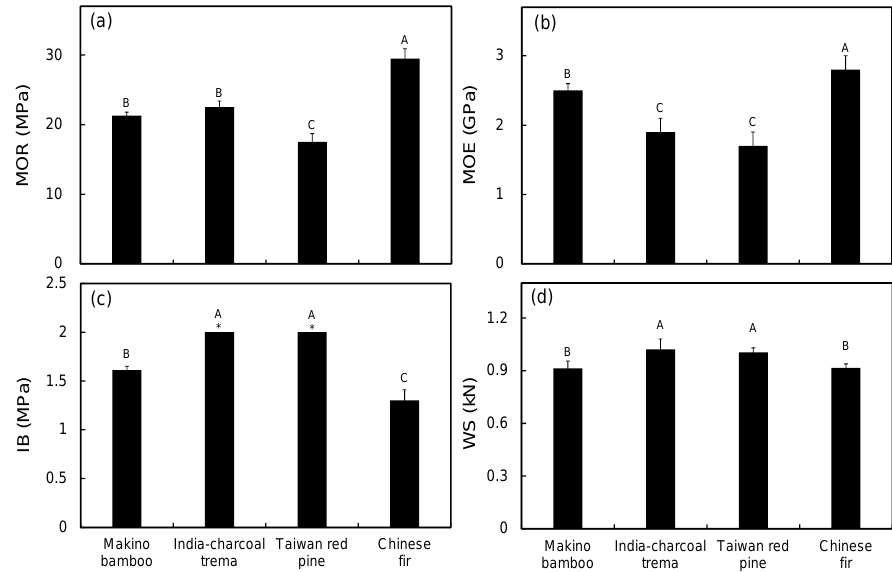
Figure 3. The MOR ( a ); MOE ( b ); internal bond strength (IB) ( c ); and wood screw holding strength (WS) ( d ) of WPCs made with different lignocellulosic fibers. *: IB over the test limitation (2 MPa). Values are the mean ± SD ( n = 5). Different letters indicate significant differences among groups ( p < 0.05).